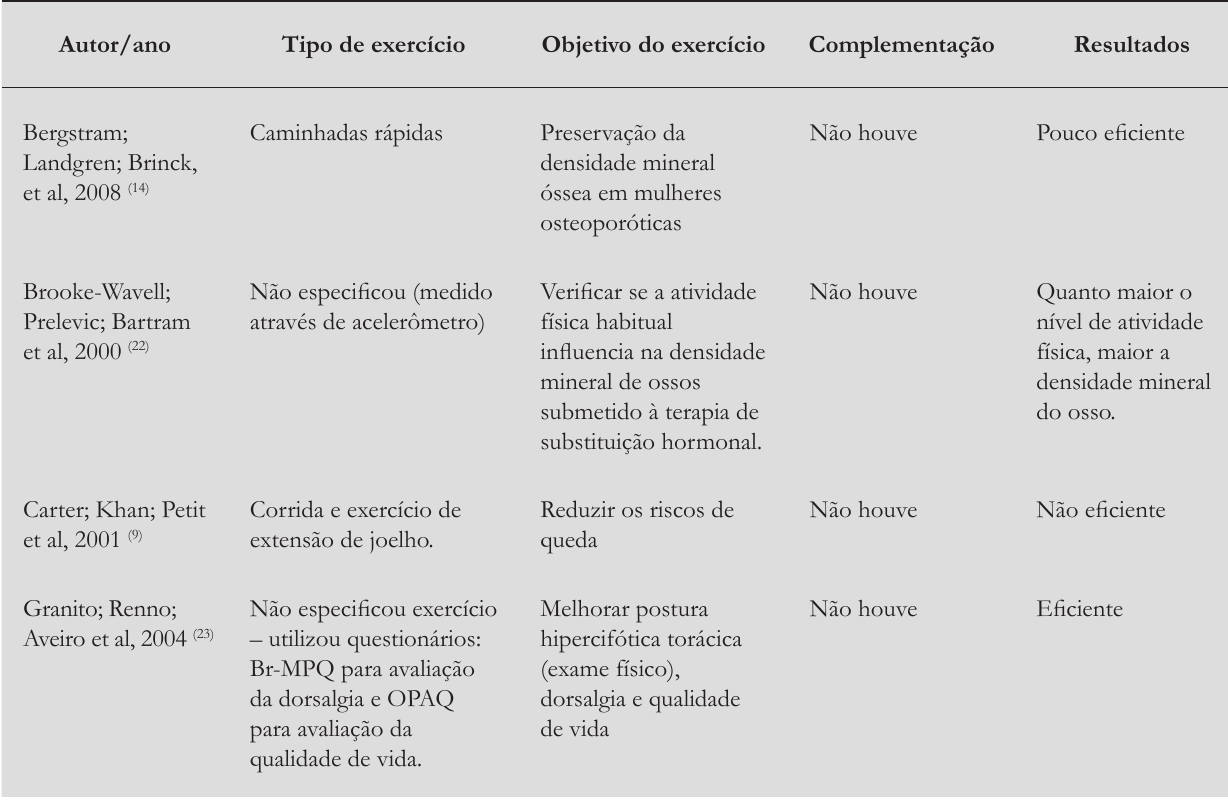
Tabela 1 - Estudos sobre exercício físico utilizados no tratamento da osteoporose segundo autor, tipo de exercício, objetivo, complementação e resultados dos exercícios